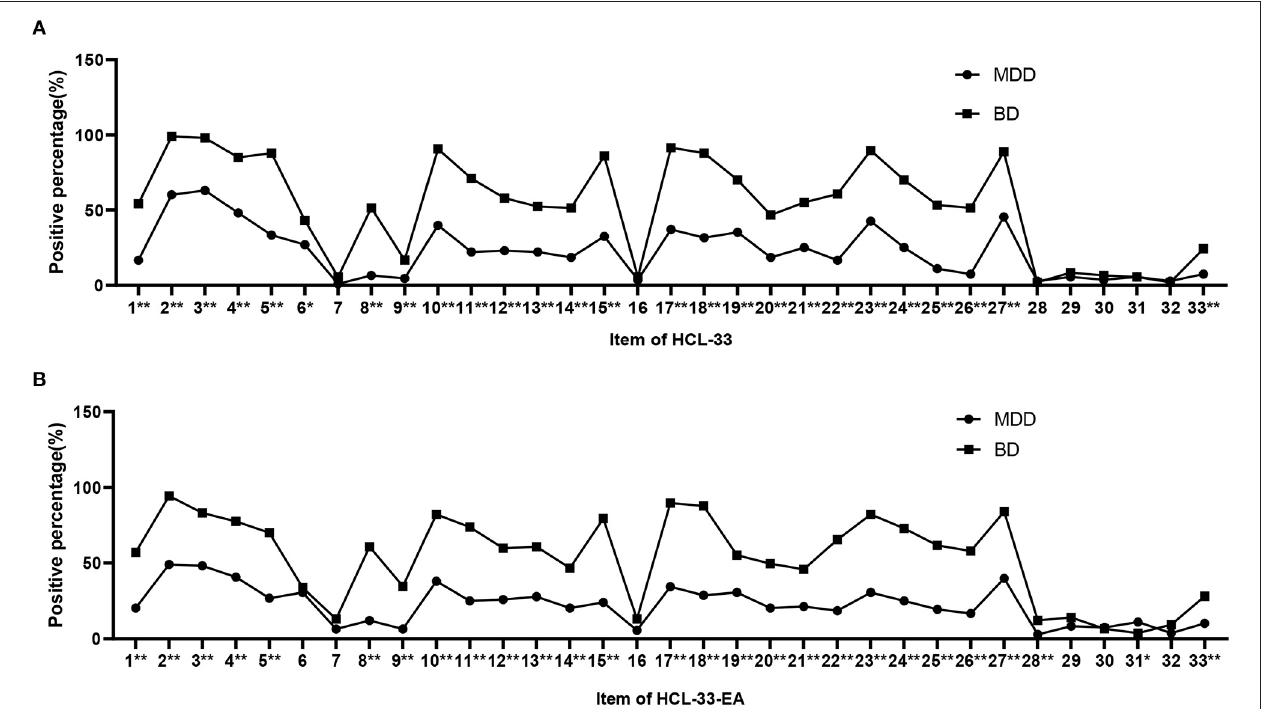
FIGURE 1 | Positive responses for items of the HCL-33 and HCL-33-EA. (A) Positive responses for items of the HCL-33 in patients with MDD and BD. (B) The positive responses for items of the HCL-33-EA in patients with MDD and BD. * P < 0.05; ** P < 0.01; BD, bipolar disorder; MDD, major depressive disorder.